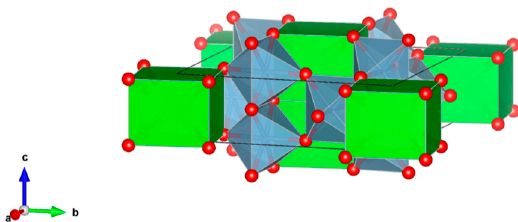
Figure 7. Hollandite. Ba 1.2 (Al,Ti) 8 O 16 . Structure tetragon, Sp. gr. I4 / m, monocl, Sp. gr. I2 / m. Cations